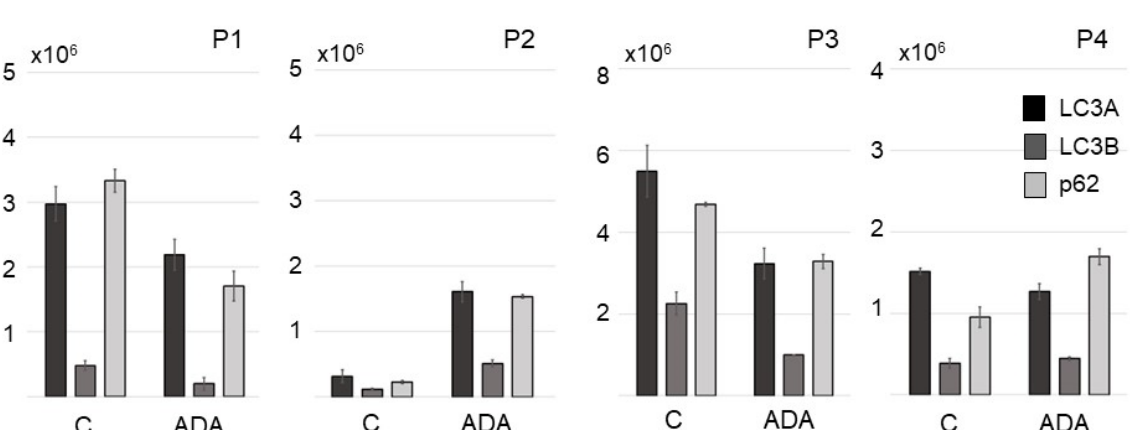
Figure 4. Comparative expression of the levels of IL-1 α ( A ), IL-5 ( B ), RANTES ( C ), MCP-2 ( D ), TNF- α ( E ), TGF- β ( F ), TNF- β ( G ), IFN- γ ( H ), IL-6 ( I ), GCSF ( J ), GM-CSF ( K ), GRO ( αβγ ) ( L ), GRO- α ( M ), IL-2 ( N ), IL-3 ( O ), IL-7 ( P ), IL-8 ( Q ), IL-10 ( R ), IL-13 ( S ), IL-15 ( T ), MCP-1 ( U ), MCP-3 ( V ), and MIG ( W ) in culture supernatants of HS lesional skin of the control group (C) and the adalimumab-treated group (ADA) maintained for 3 days in the HS 3D-SeboSkin model. Comparisons were performed against the analytical assay standard. *** = p < 0.001, ** = p < 0.01, * = p < 0.05, ns = not significant.